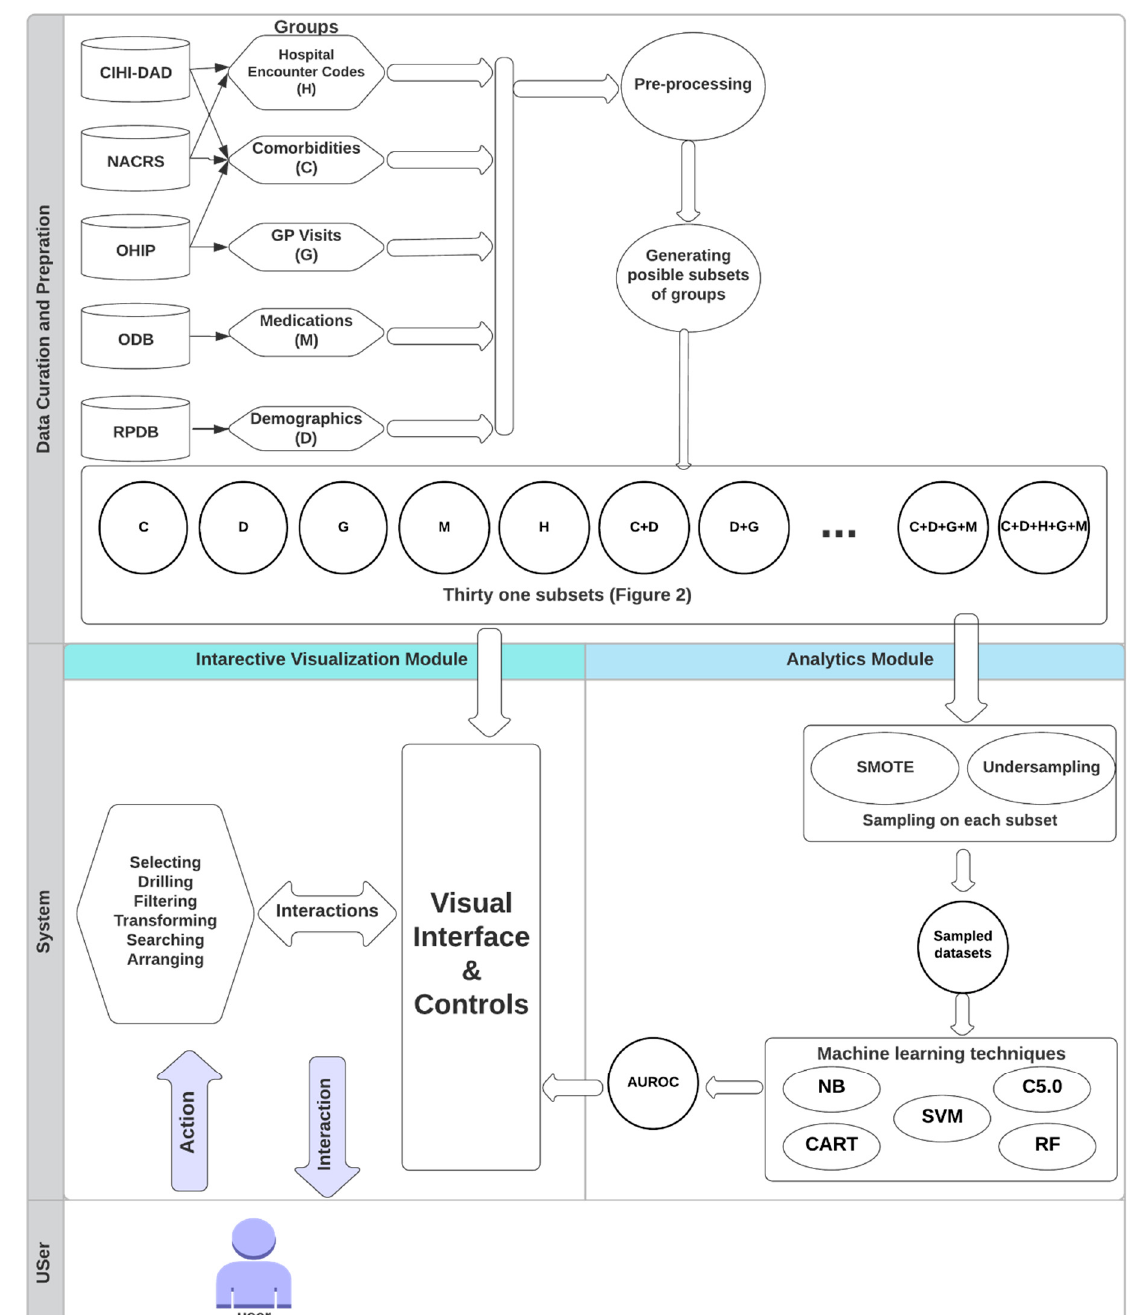
Figure 1. The workflow diagram of VERONICA.